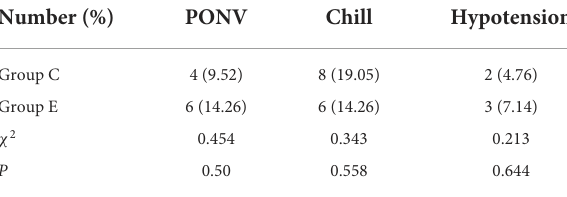
TABLE 8 Comparison of complication